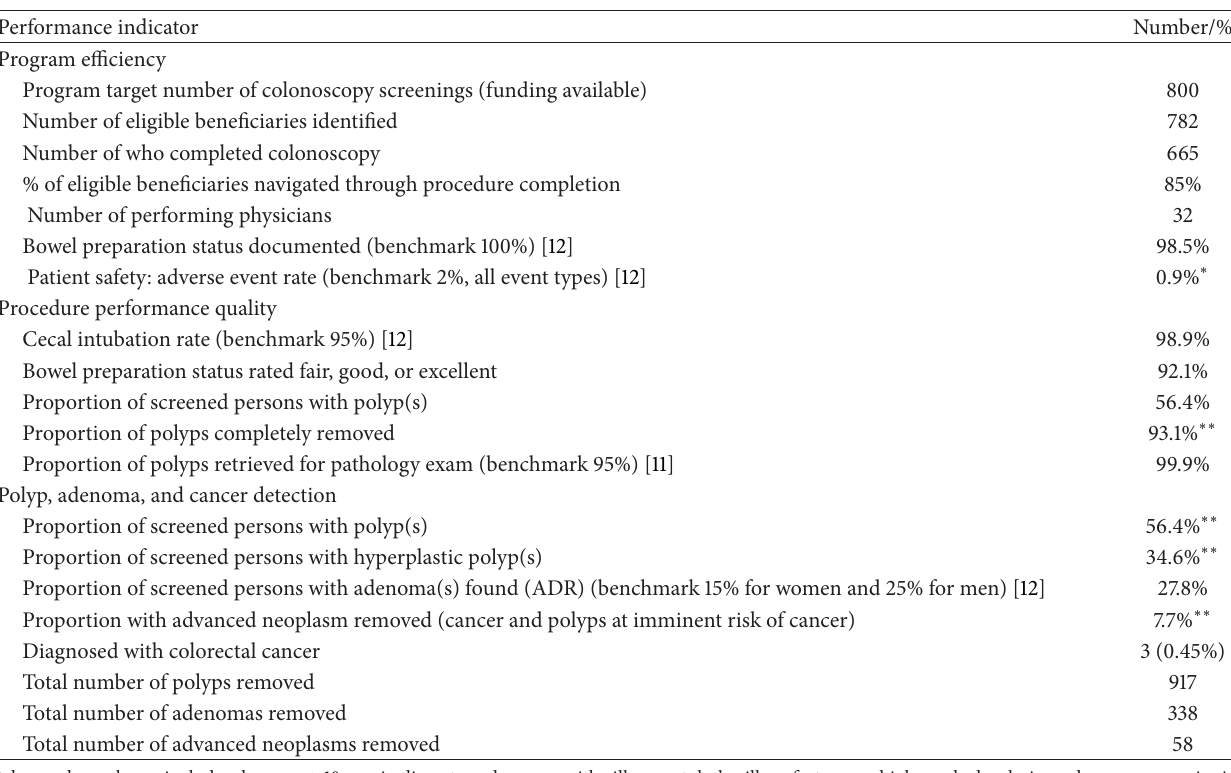
Table 1: SCOPE SC program performance in year 1: efficiency of patient recruitment, effectiveness of procedure performance, and patient